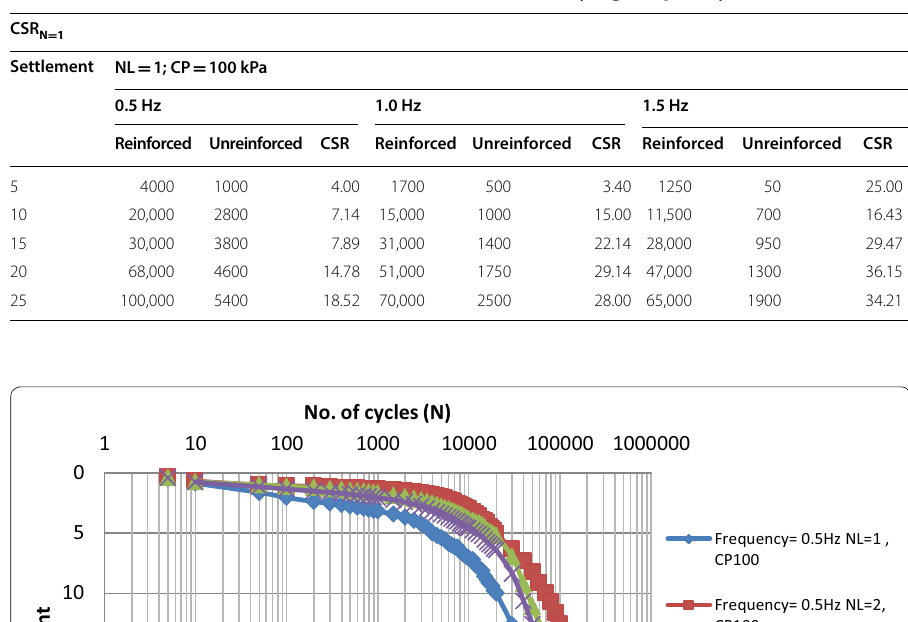
100 kPa under varying frequency =